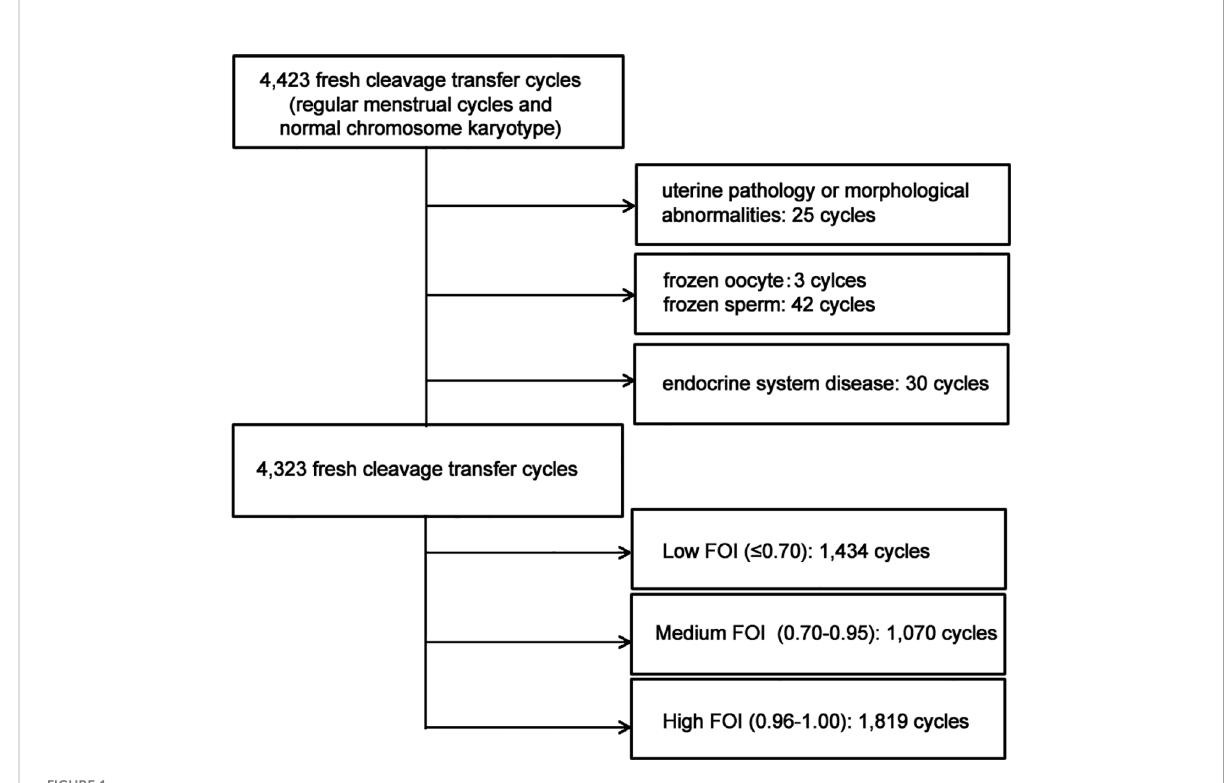
FIGURE 1 Flow chart of participant